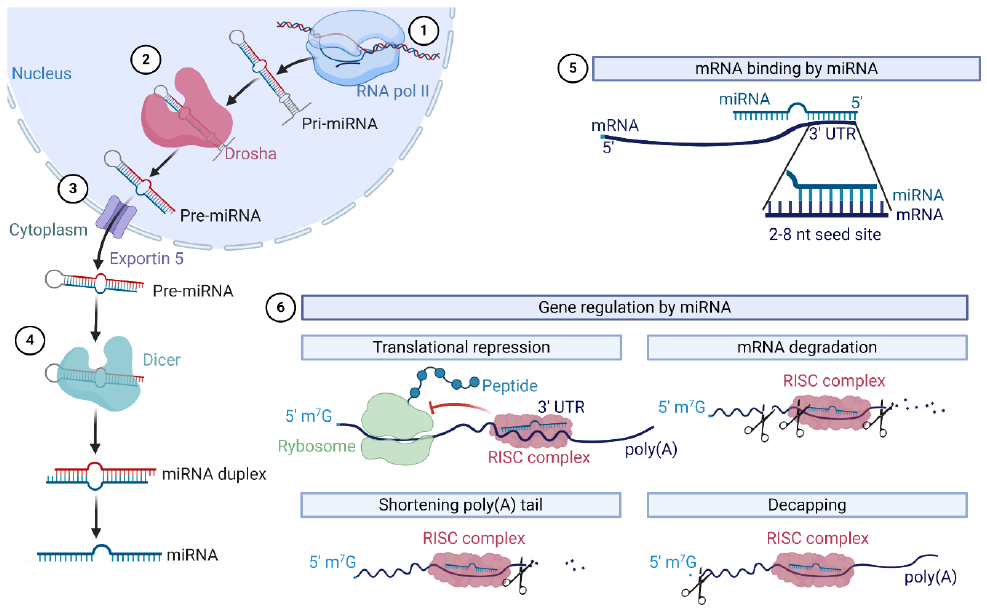
Figure 1. MiRNAs biogenesis and the mechanism of mRNA regulation. The crucial steps